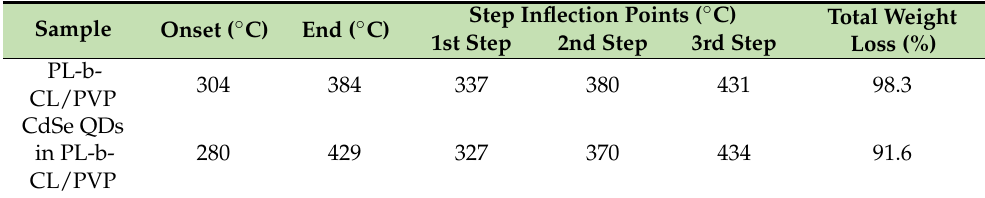
Table 3. Data after TGA analysis of pristine and functionalized